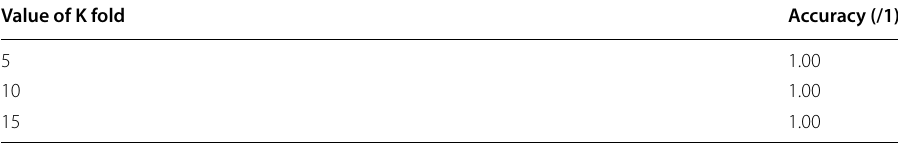
Table 6 KNN model accuracy